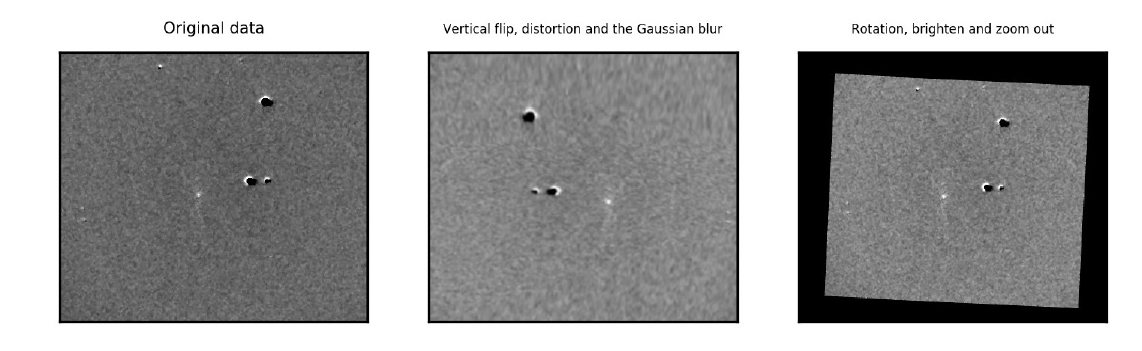
Figure 3. Sample images in the Popular Supernova Project augmented